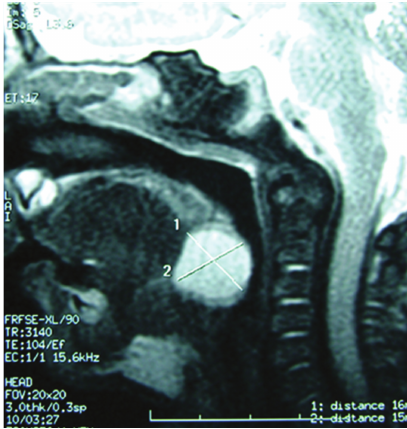
Figure 2: MRI in sagittal view shows a large cystic mass at the tongue